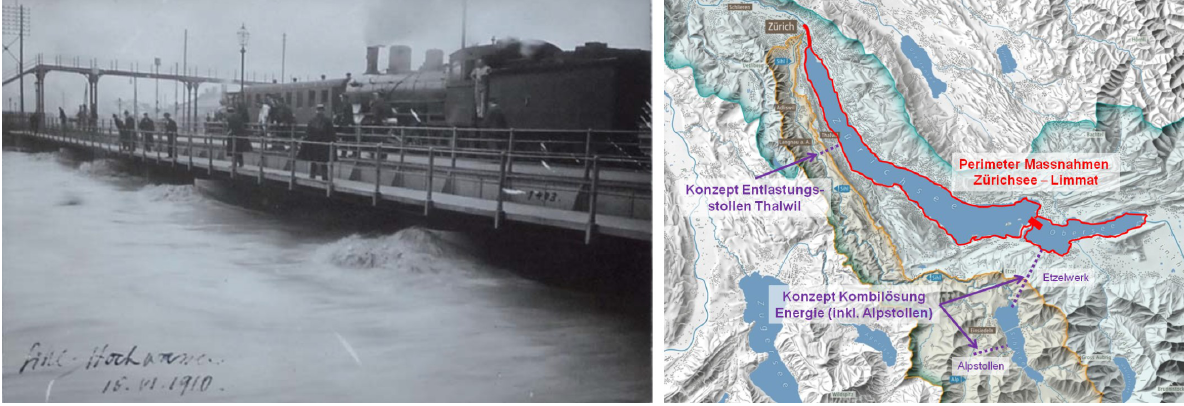
OSM is overlain by moraine deposits. All the rock properties are summarized in Table